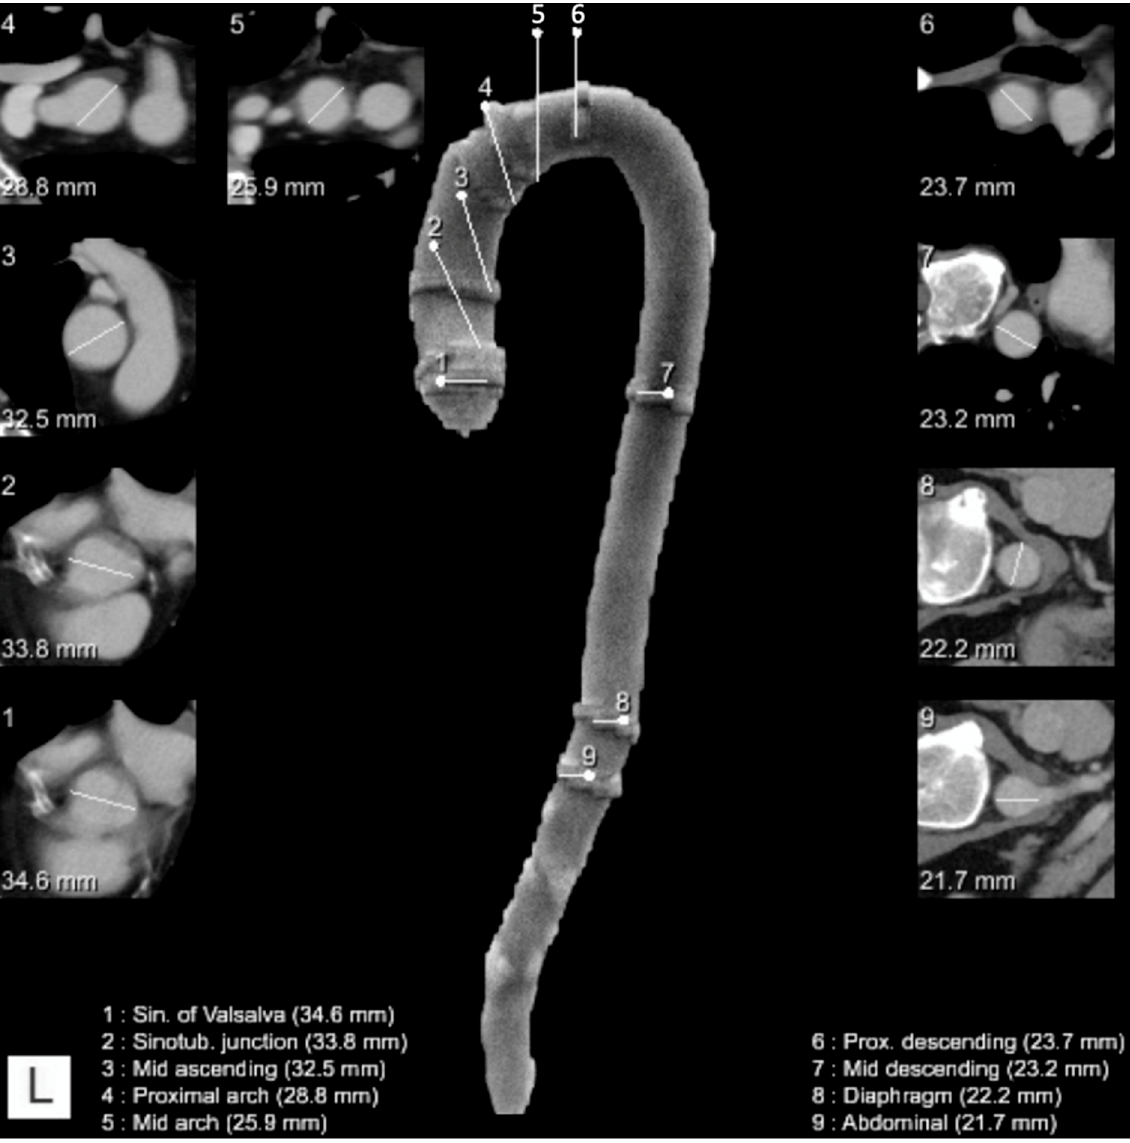
Figure 2. Example of a reconstruction of the thoracic aorta with location and diameter of the measure- ments at each dedicated location (legend on the bottom of the image describing the location and the measured diameter). White lines: measurements of the diameter at each dedicated location. In frame images (numbered 1–9 in the top left corner): depiction of the automated diameter measurements in the respective planes perpendicular to the center